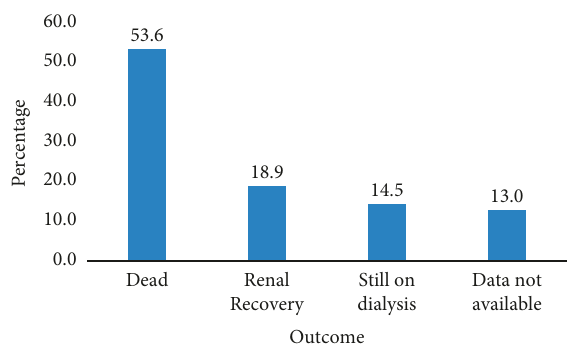
Figure 2: Outcomes of patients enrolled to the haemodialysis centre of Ayder Hospital in the year